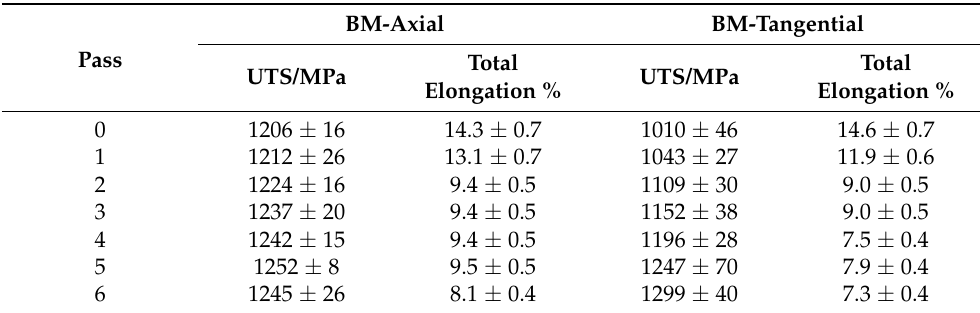
Table 4. Comparison of mechanical properties between the 6-pass spun tube in axial and tangential direction (Base metal).